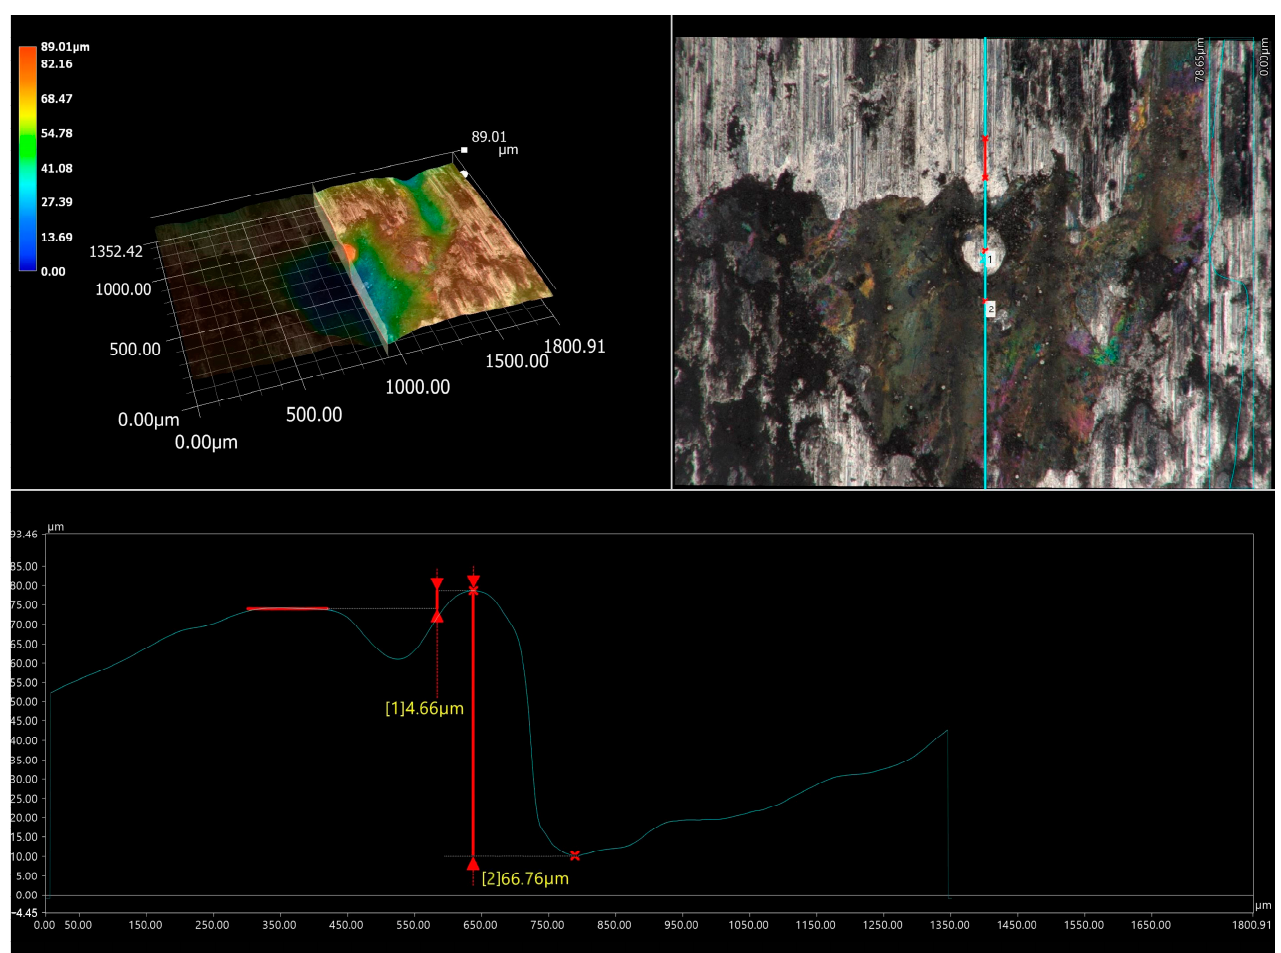
Figure 16. The cross-section of the 3D image of the surface topography and the 2D profile across the WC particle after the wear resistance test performed for the specimen laser-alloyed with a laser beam power of 1.3 kW; 1, 2—measuring points of the relative height of the WC particle.